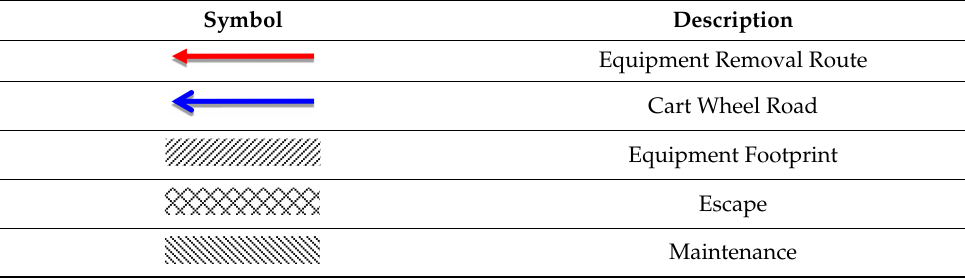
Figure 4. Material handling route: process deck ( left ) and upper deck ( right ). Table 2. Material handling symbol